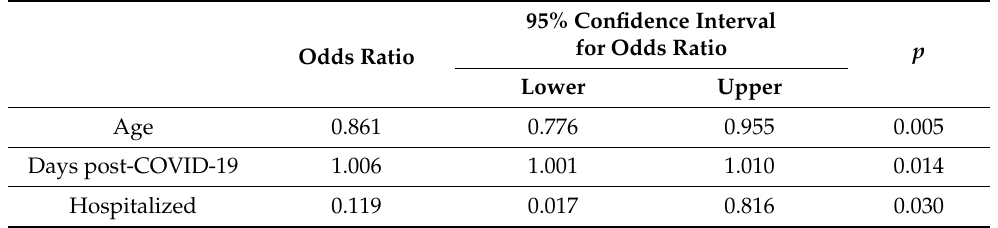
Table A1. Sensitivity analysis. Logistic regression to predict achievement of 85% maximum predicted HR during exercise (N = 68 participants who were aged 35 and over and at least 90 days post- COVID-19). The model converged in 6 steps. Variables entered on step 1: age, body mass